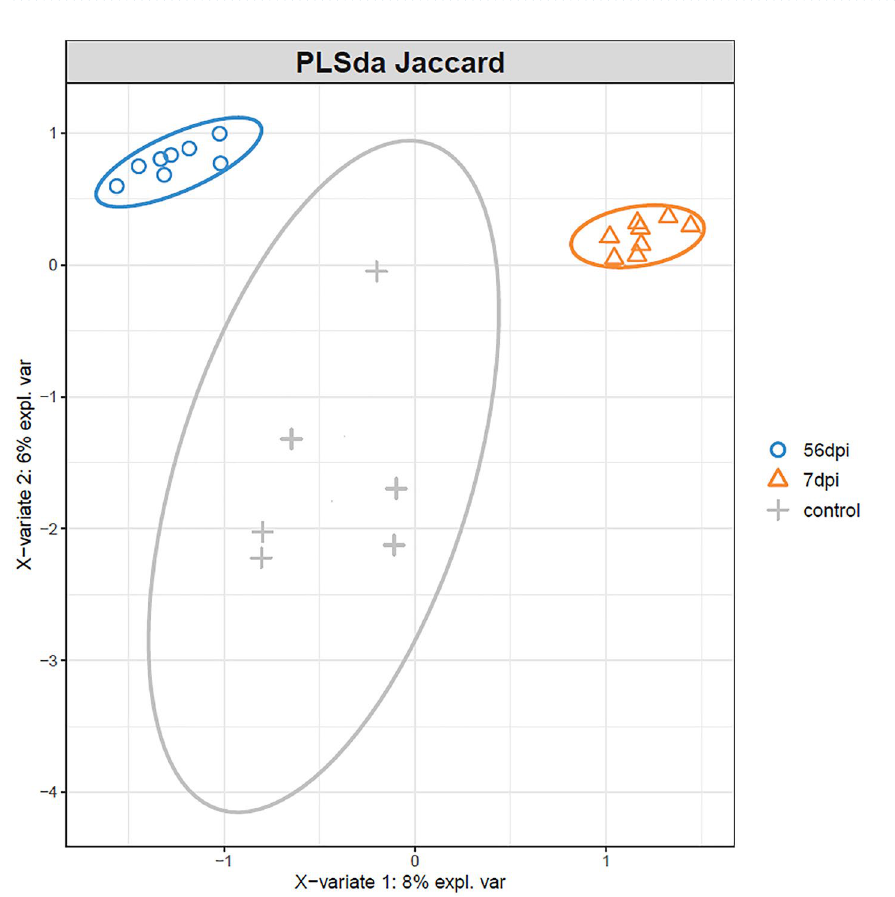
Figure 3. Abomasal microbiota profile of Creole goat kids comparing time points after infection with 10,000 H. contortus infective larvae (L3), ordinated by PLS-Discriminant Analysis (PLS-DA). 56 dpi (56 days post- infection), 7 dpi (7 days post-infection) and Control